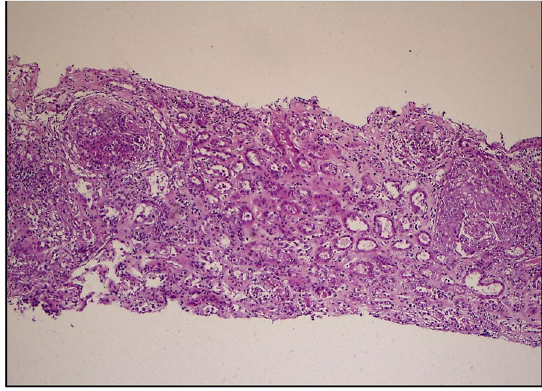
Fig. 2 Pathological findings (PAS 10x). Renal biopsy with cellular crescentic lesions, without tubular atrophy or significant interstitial fibrosis